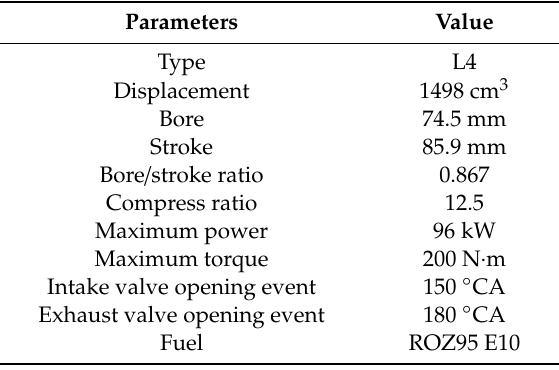
Figure 1. Structure of the investigated P3 hybrid electric vehicles (HEV) powertrain. Table 1. Gasoline engine